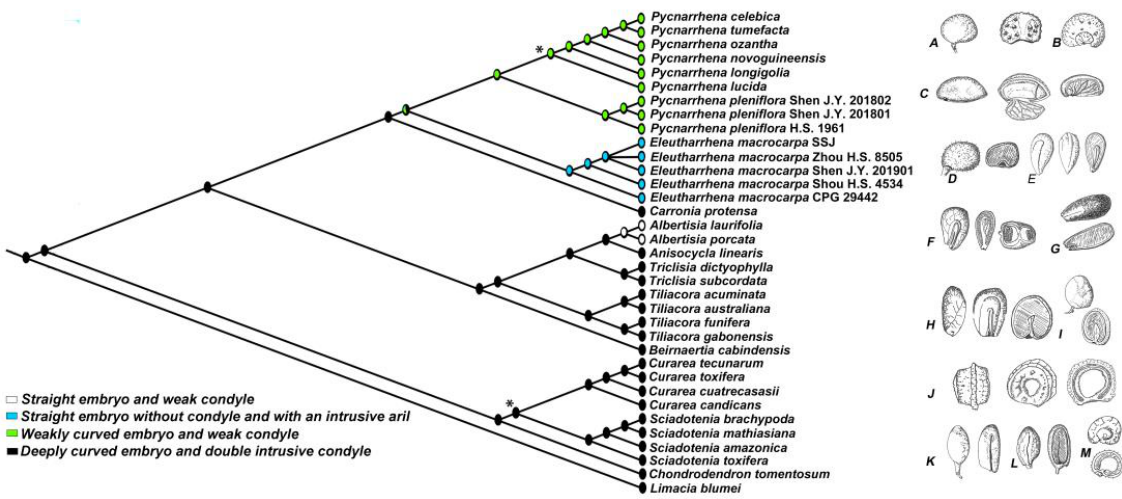
Figure 4. Endocarp characteristics mapped on the Bayesian phylogenetic tree of Tiliacoreae using mesquite. All nodes have more than 0.9 posterior probabilities (PP) support except when noted with *, meaning less than 0.8 PP. Endocarp illustrations: A. Pycnarrhena pleniflora ; B. Pycnarrhena ozantha ; C.